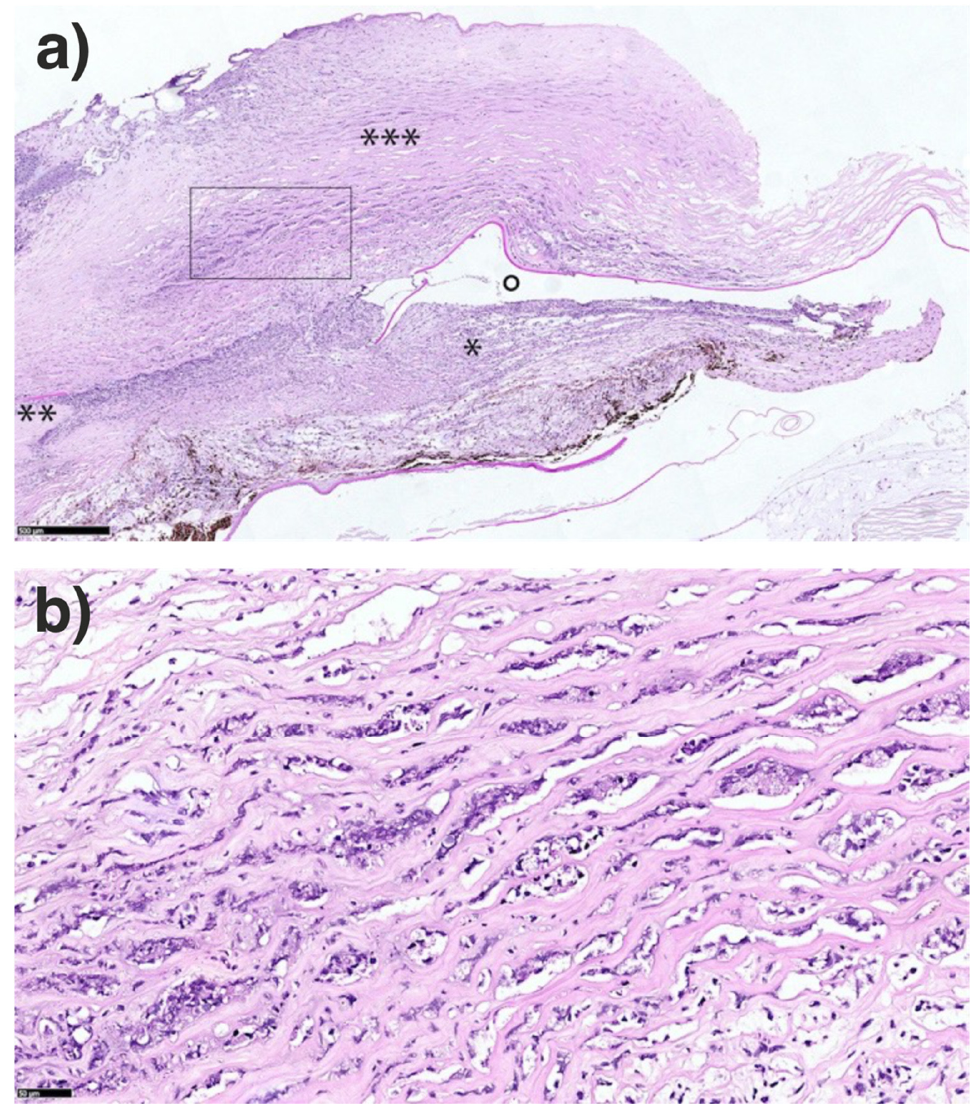
Figure 7. Histopathological examination of the anterior segment. ( a ) Necrotizing inflammatory reaction consisting of neutrophil granulocytes mainly in the cornea (***) and adjacent chamber angle (**), iris (*) and anterior chamber (°). Periodic acid Schiff stain, bar = 500 µm. ( b ) Enlarged area inside the square of figure A containing necrotic neutrophil granulocytes between the corneal stroma lamellae (Periodic acid Schiff stain, bar = 50 µm).